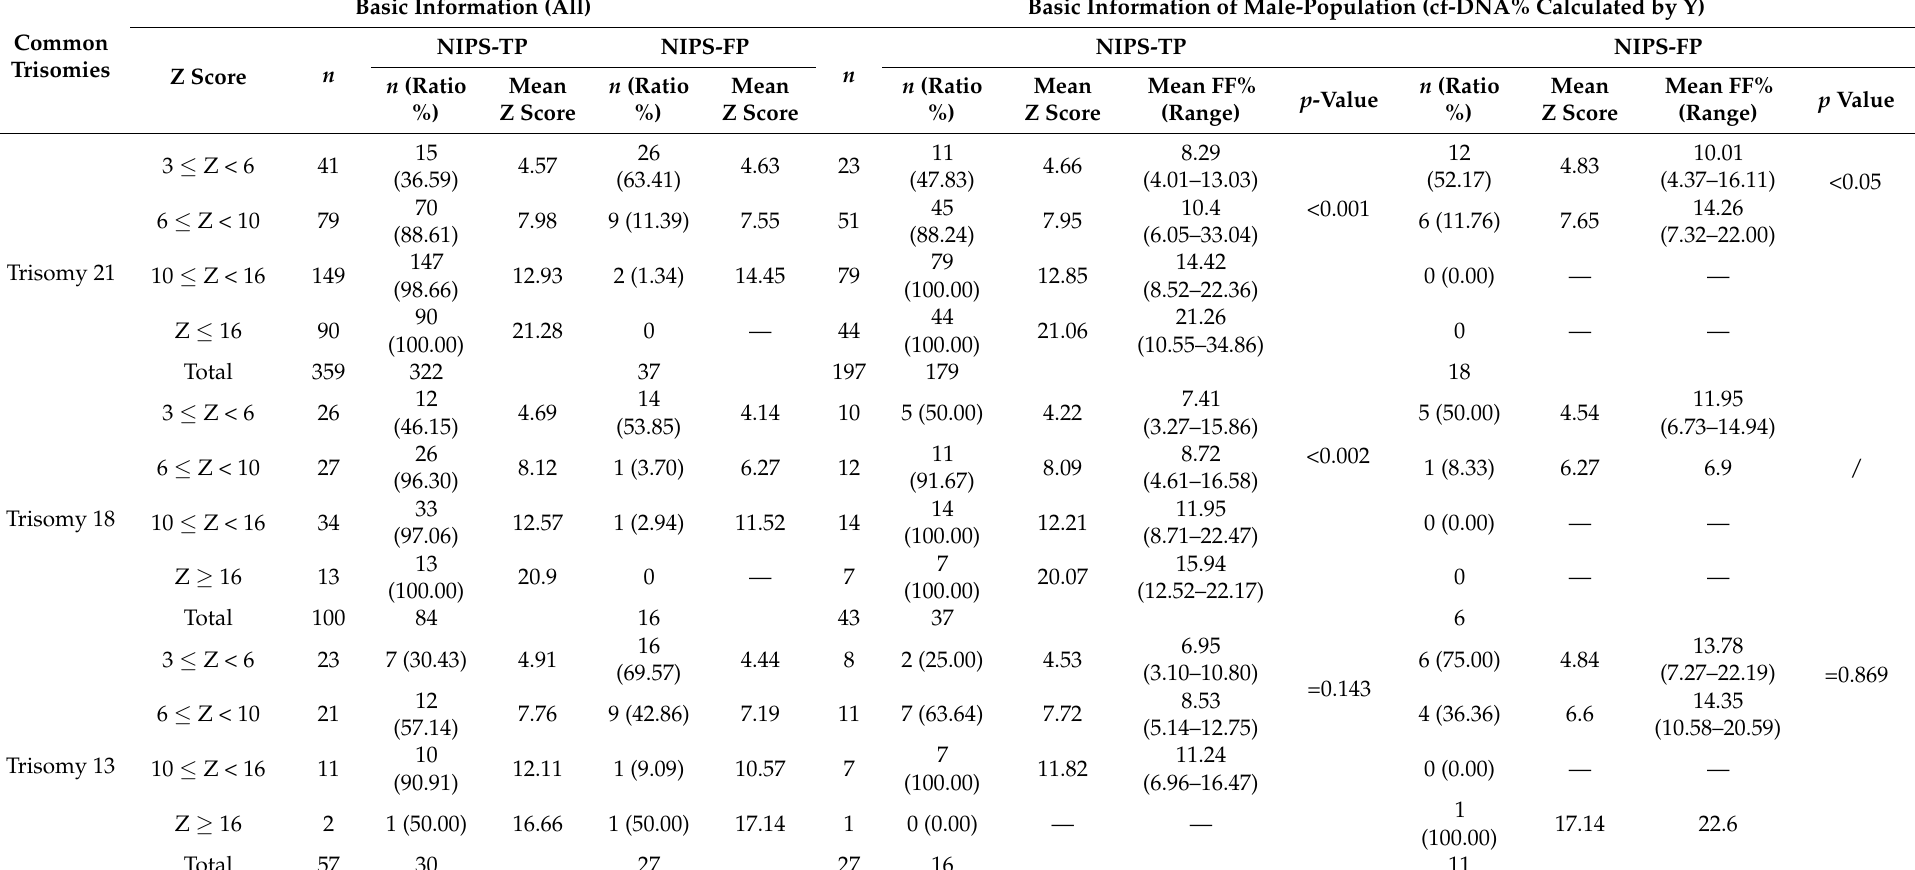
Table A1. The relationship between Z score and fetal fraction in common trisomies by